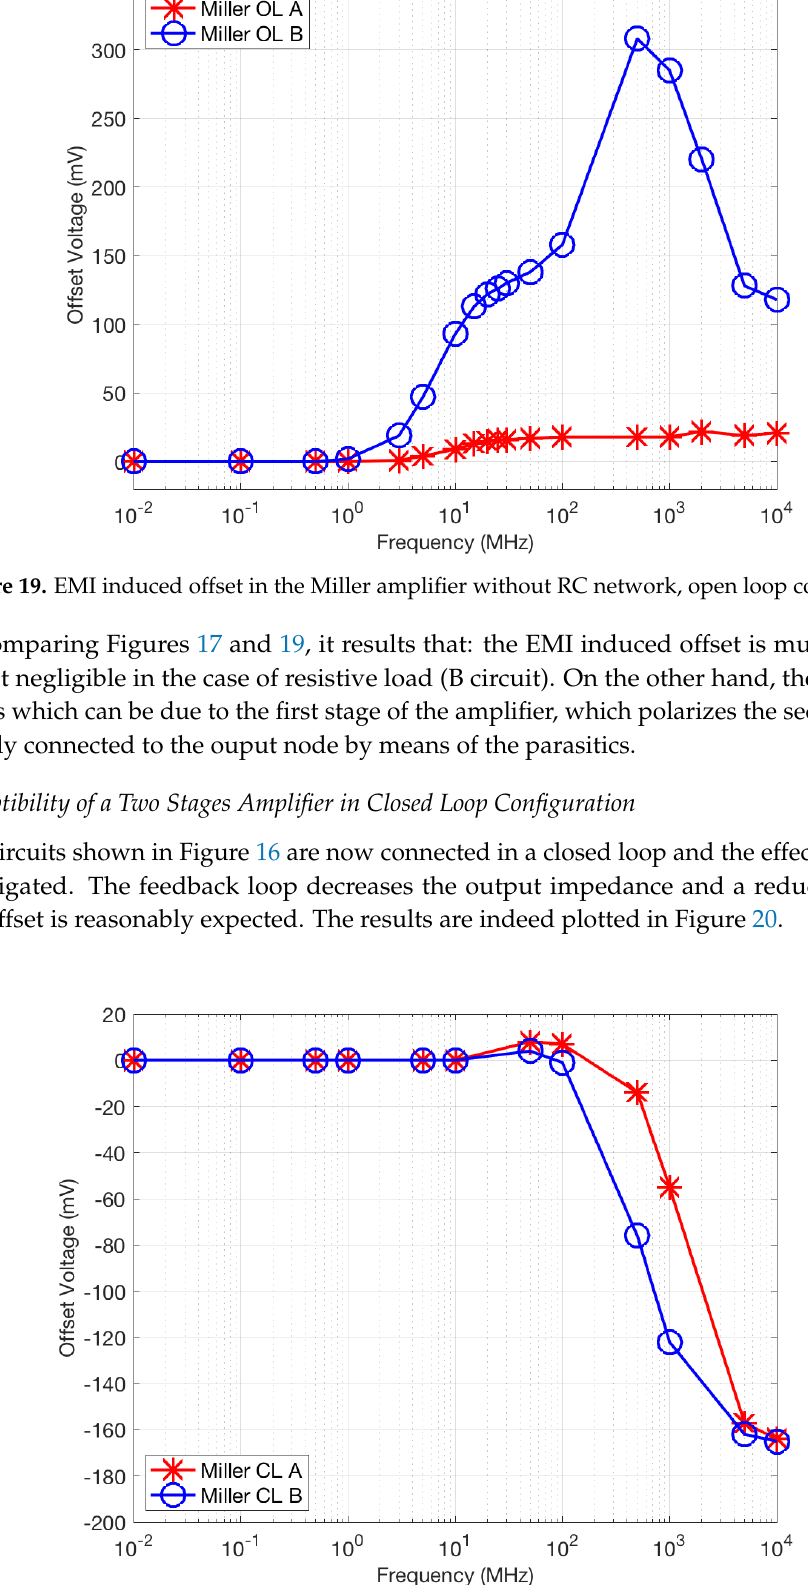
Figure 20. EMI induced offset in the Miller amplifier with RC network, closed loop